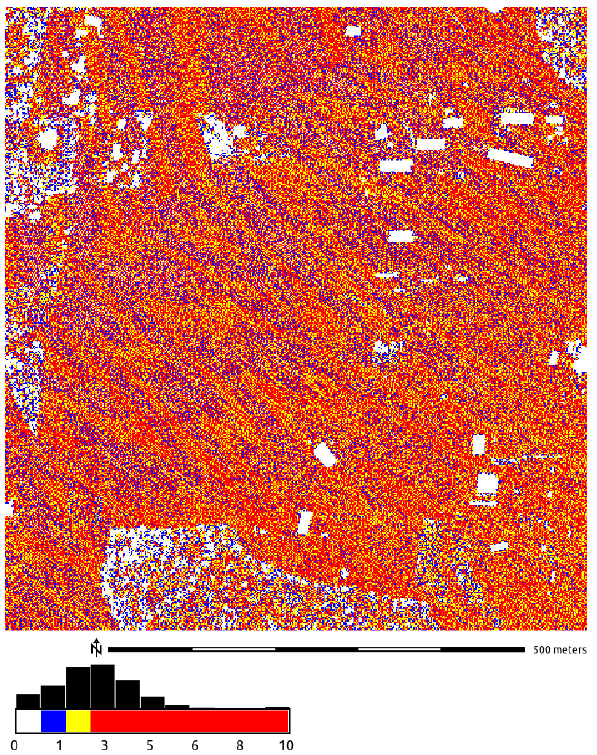
Figure 1: The number of points per cell for point cloud obtained using airborne lidar (raster resolution 1.5 m)